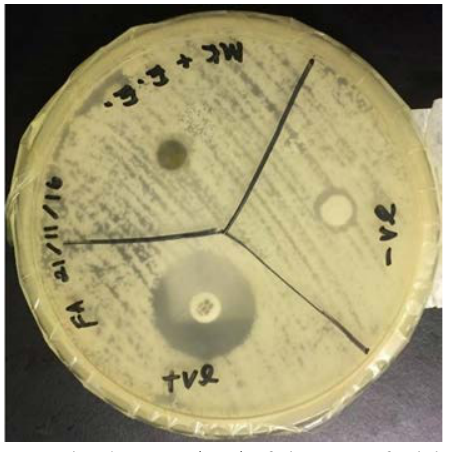
Fig. 1. The diameter (mm) of the zone of inhibition produced by the Etlingera elatior Jack. extracts tested on Candida albicans